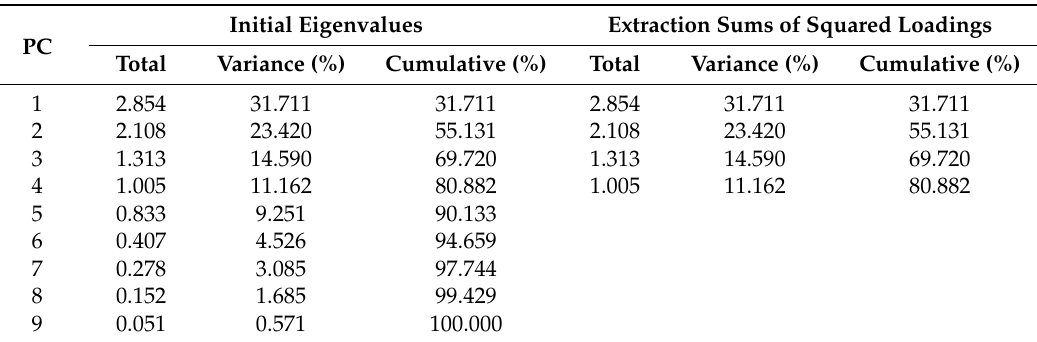
Table 6. Total variance explained for raw (RW)